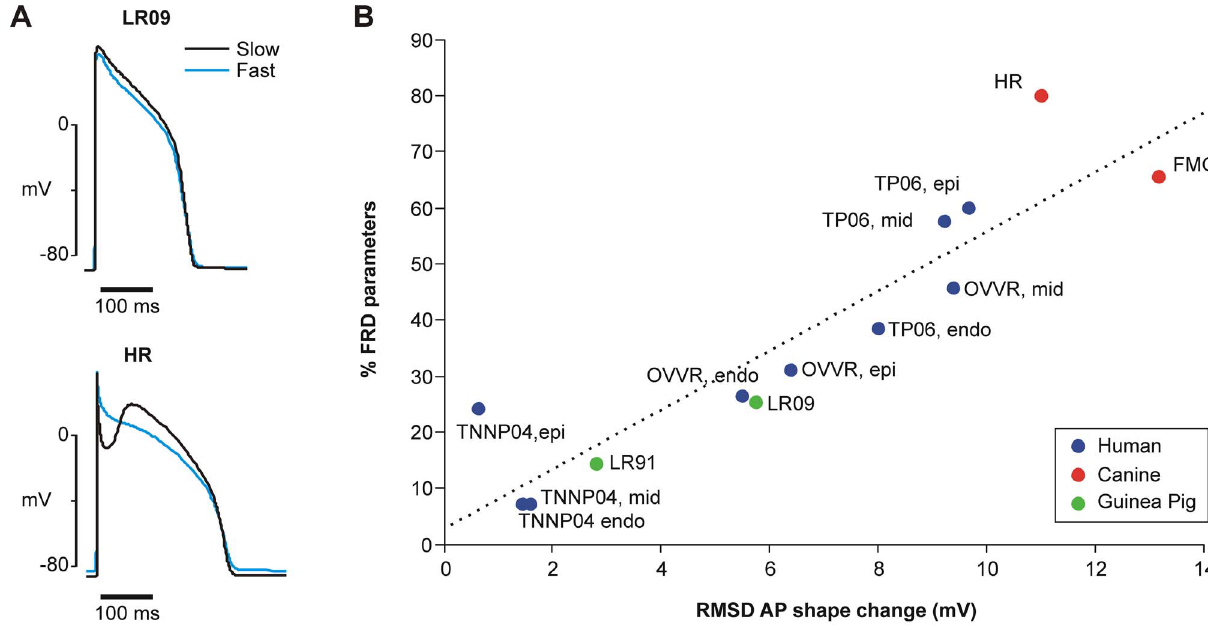
Figure 5. Rate-dependent change in AP contour corresponds to capacity for forward rate-dependence. ( A ) AP traces for a model with mostly RRD parameters (LR09) and a model with mostly FRD parameters (HR). Each trace was calculated after pacing to steady state at each rate. For each model, the fast AP was rescaled with respect to time such that APD slow =APD fast , to isolate AP contour changes independent of APD changes. Rate-dependent contour change is quantified by the root mean square deviation (RMSD) between the rescaled AP traces at fast and slow pacing. ( B ) A strong correlation (R 2 =0.8366) was observed between the RMSD and the percentage of model parameters that are FRD.